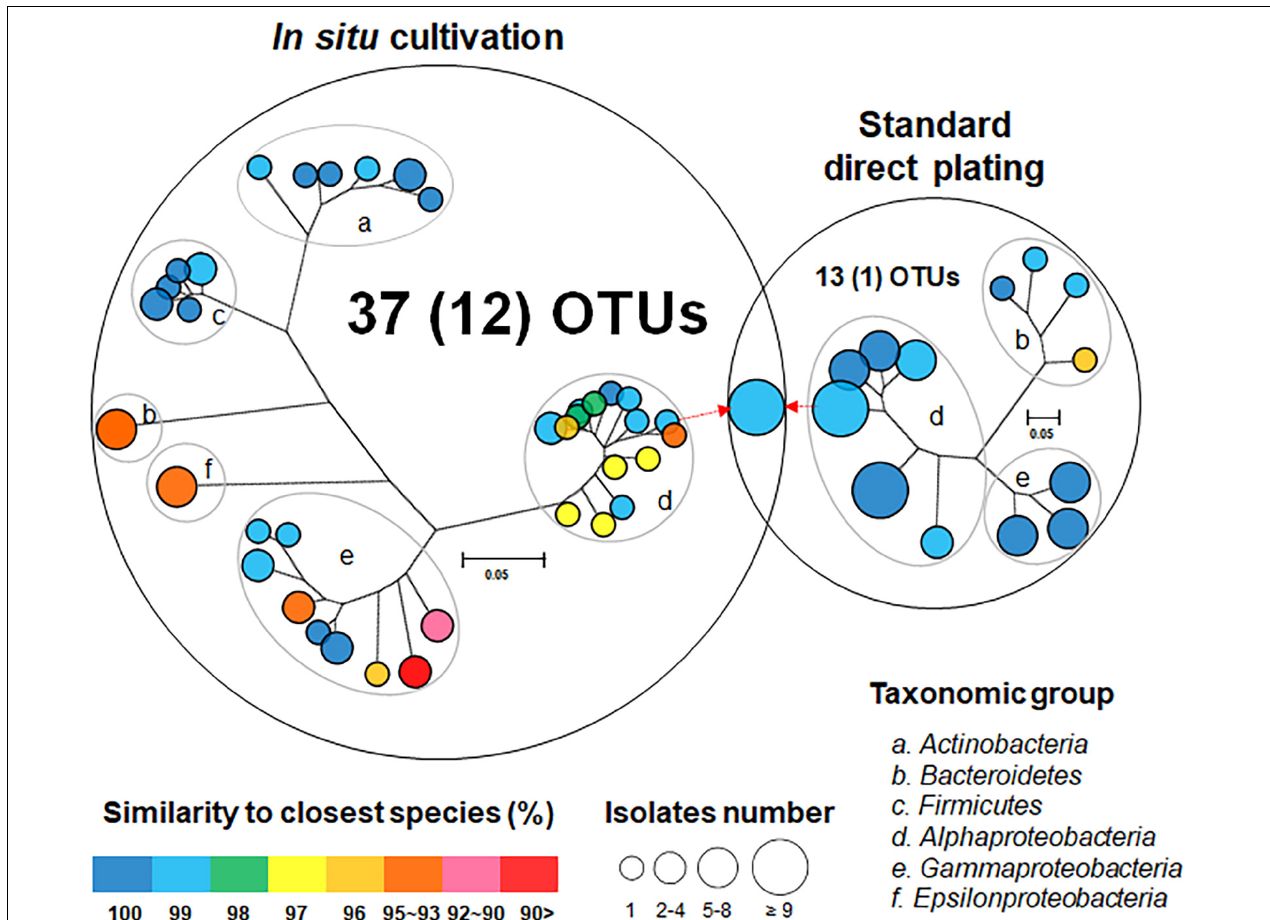
FIGURE 2 | Venn diagram consisting of phylogenetic trees based on the 16S rRNA gene of isolates from each cultivation method. The trees are maximum-likelihood trees (fast bootstrap, 1,000 replicates). Circle size and color represent the number of OTUs (defined at 97% 16S rRNA gene sequence identity) and 16S rRNA similarity to the closest known relative in GenBank, respectively. Represented isolates are also grouped into taxonomic groups (a–f) at the phylum level (class level for Alpha , Gamma , and Epsilon Proteobacteria ) by gray elliptical circles. Circles with pointed arrows indicate species that are overlapped among the isolates in the different cultivation methods. The numbers in parentheses show the numbers of novel species. The outer circle area corresponds to the number of isolated OTUs from each cultivation